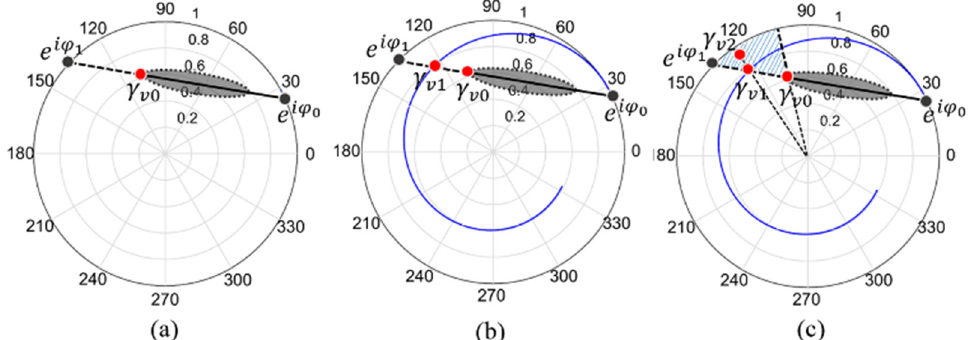
Figure 3. Schematic view of the complex unit circle for the TF-RVoG model. ( a ) The coherence line is fitted with the sublook coherences and intersects the unit circle at two points e i ϕ 0 and e i ϕ 1 . ( b ) Pure volume coherence γ v 1 is located in the dotted line between e i ϕ 1 and γ v 0 , which is caused by the impact of the residual ground scattering error. ( c ) Temporal decorrelation error results in the ambiguous area of pure volume coherence γ v 2 being spread over the striped 2-D region.